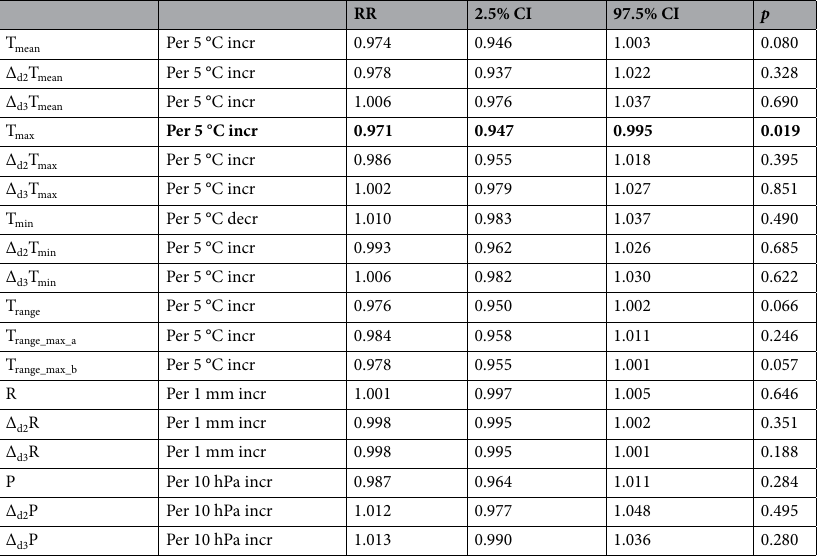
Table 2. The association of metereological parameters with admissions for hypertensive disease in a quasi Poisson model adjusted for seasonality and long term trends with spline. p < 0.05 was regarded significant (bold type). T—temperature, R—rainfall (precipitation), P—athmospheric pressure; Δ d2 —change within two days, Δ d3 —change within three days, T range : daily range of temperature, T range_max : maximum temperature range within two days